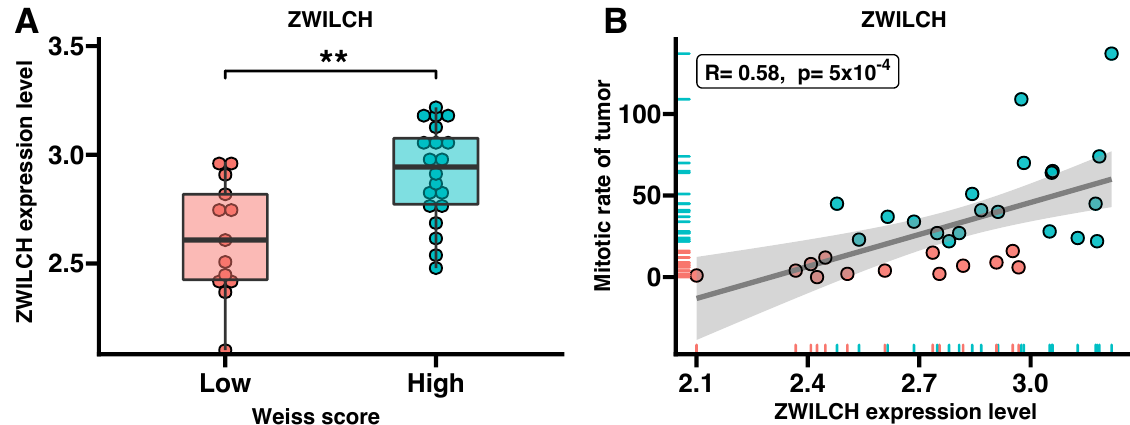
Figure 4. The expression of the ZWILCH gene in the group of patients with adrenocortical carcinoma according to Weiss score (Mann–Whitney U nonparametric test, ** p < 0.01) ( A ). Strong positive correlation of ZWILCH gene expression with the mitotic rate of tumor (R = 0.58, p = 0.0005) ( B ). The red dots represent patients with a low value of the Weiss score, while the turquoise dots represent a high value of the Weiss